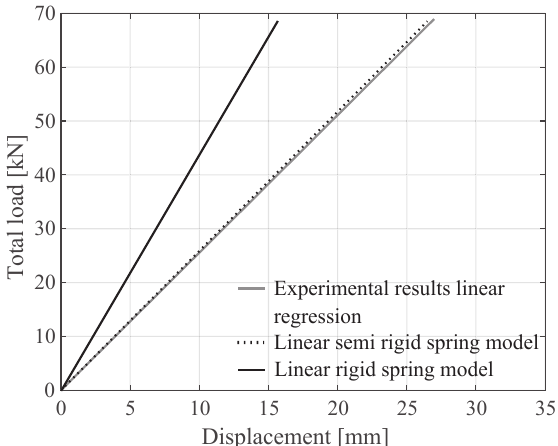
Figure 20. Comparison of semi-rigid and rigid spring model results. Total load vs. maximum vertical